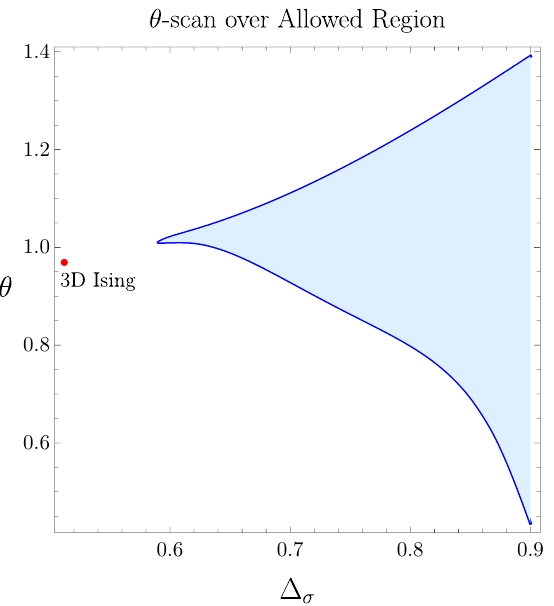
Figure 2 . A plot showing how the allowed range of (cid:18) , taken over all (cid:1) (cid:15) , grows on the non-excluded region of CFTs. In this plot we use (cid:3) =